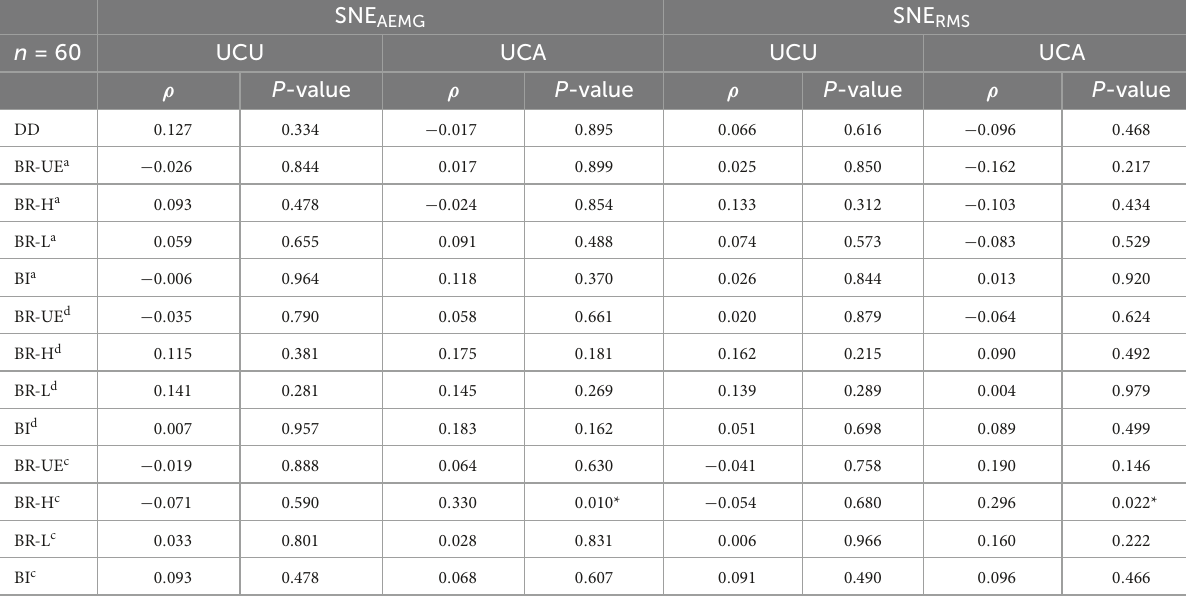
DD,diseaseduration;BR-UE,Brunnstromstageofupperextremity(shoulderandelbow);BR-H,Brunnstromstageofhand;BR-L,Brunnstromstageoflowerextremity;BI,Barthelindex; a assessmentatadmission; d assessmentatdischarge; c theimprovementofassessmentscore.* p <